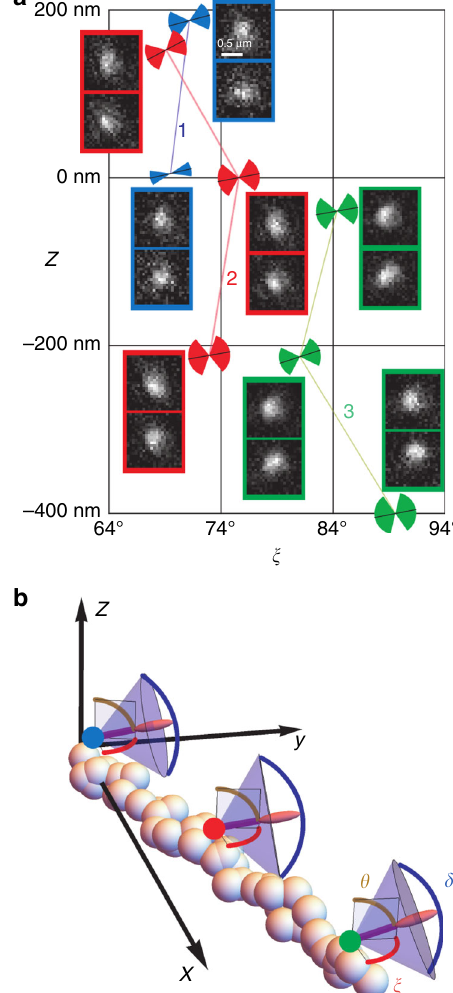
Fig. 7 CHIDO imaging of three Alexa Fluor 488 single molecules sparsely attached to a F-actin fi lament. a The insets show zooms of the images of the RHC/LHC components on the top/bottom for three different z defocus (only high-con fi dence retrieval is shown). These images are labeled by the color of the frame: blue for molecule 1, red for molecule 2, and green for molecule 3. The estimated in-plane angle ξ and height z are represented as coordinates in this plot, where the PSFs used to retrieve the corresponding values are placed closest to the corresponding point. The out-of-plane angle θ and wobble angle δ are represented by the orientation and angular extent of the sketched cones. b 3D representation of the orientation and wobbling retrieval for defocus z close to 0. Numerical values are given in Table